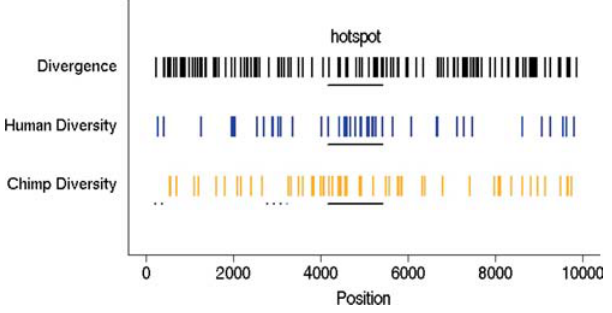
Figure 4. Distribution of Variable Sites in the Genomic Region The positions of sites that differ between humans and chimpanzees are shown on the first line, while the positions of sites polymorphic in humans from the UK or in western chimpanzees are shown on the next two lines. The human hotspot region is underlined. The dashed lines indicate regions not surveyed for variation in western chimpanzees (see Materials and Methods). DOI: noted by Jeffreys et al. (2000), there is a significant excess of diversity within the hotspot region in humans from the UK (Figure 4): when the hotspot region is compared to the 8,735 other windows of the same size, only 0.3% have as many or more SNPs. In contrast, in western chimpanzees, levels of diversity are not higher than elsewhere in the region (Figure 4): 17.0% of comparable windows harbor at least as many SNPs as the hotspot. Nor are levels of human–chimpanzee divergence unusual in the hotspot region: 67.3% of windows show the same or higher numbers of fixed differences between species (Figure 4). Given the evidence for a recombination hotspot in humans but not in chimpanzees, these observations are consistent with an association between